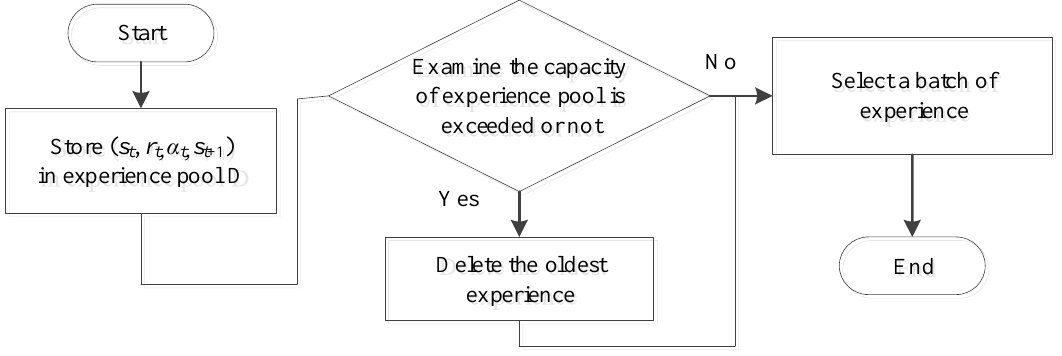
Figure 12. Flowchart of the storage and selection stage.